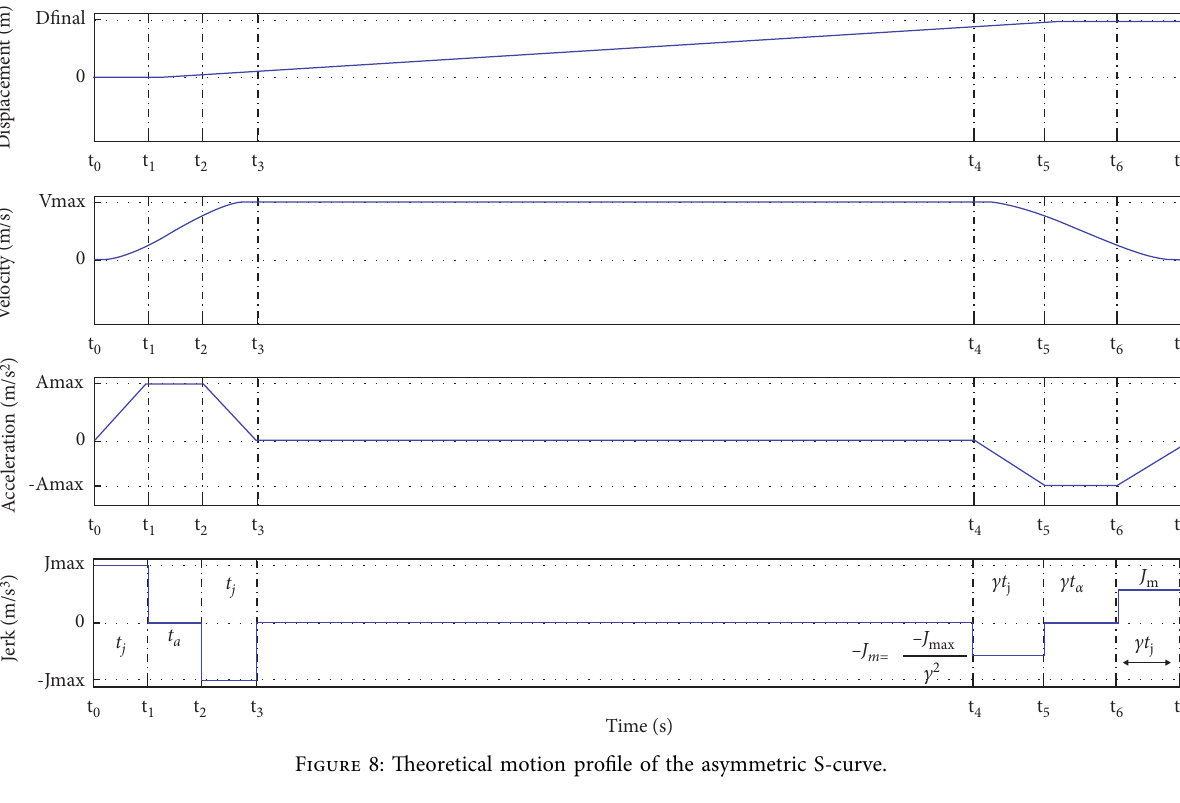
Figure 8: Theoretical motion profile of the asymmetric S-curve.